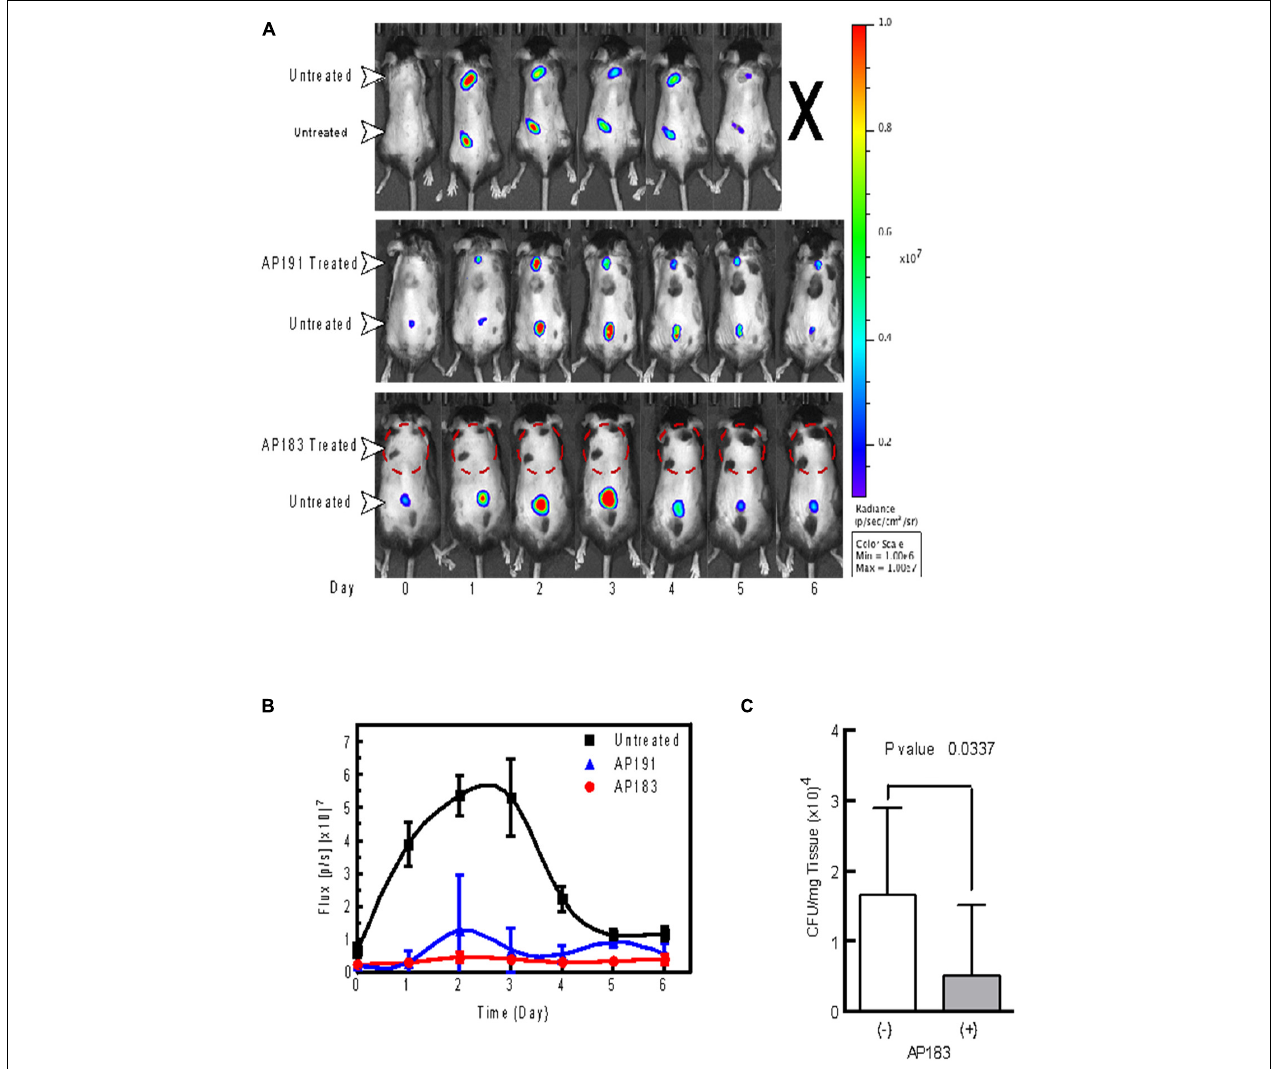
FIGURE 1 | In vivo evaluation of B. velezensis strains AP183 and AP191 inhibition of S. aureus Xen29 in a cutaneous wound model. Mice were given subcutaneous injections of 1 × 10 6 CFU/mL of S. aureus Xen29 between the shoulder blades and on the lower back. (A) Upper panel, untreated mouse that succumbed to systemic infection 5 days after initial cutaneous wound challenge. Center panel, mouse treated with B. velezensis AP191 culture on upper wound and untreated in the lower wound. Lower panel, mouse treated with B. velezensis AP183 culture on upper wound and untreated in the lower wound. (B) Bioluminescent flux (photons/second) of S. aureus Xen29 in AP183/AP191 treated wounds and untreated controls over time. (C) CFU determined for AP183 treated and untreated wounds from excised homogenates plated on TSA.